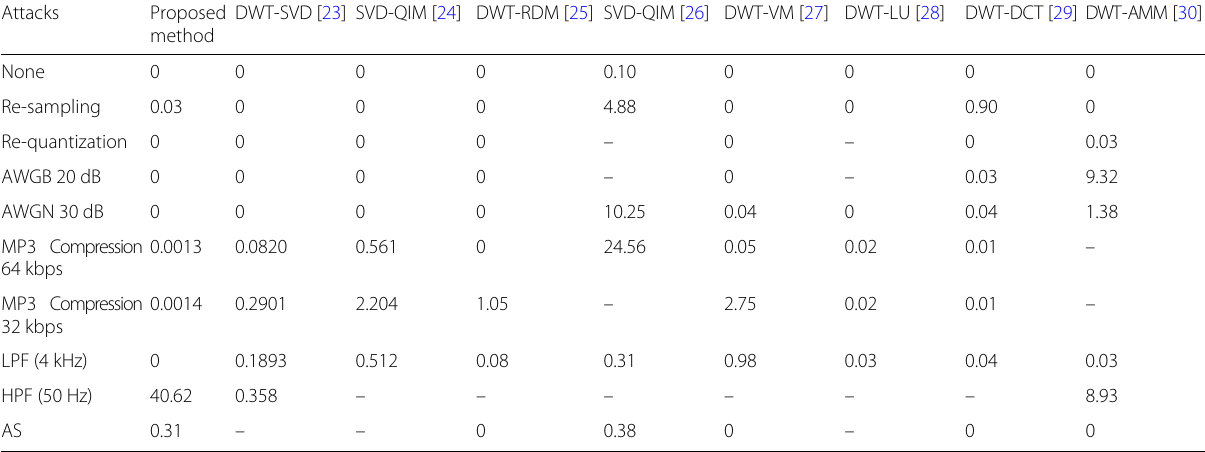
Table 3 Average BER results of the proposed DCT-SVD-based watermarking technique compared with other watermarking techniques